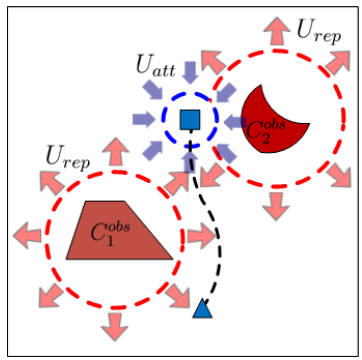
Figure 7. Attractive and Repulsive force